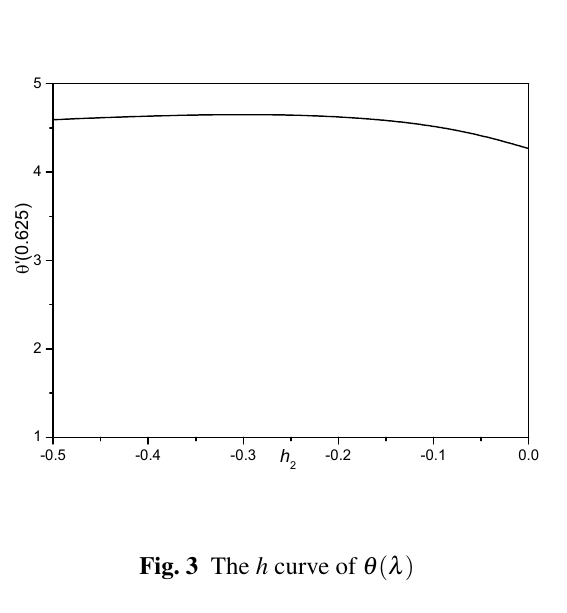
Fig. 2 The h curve of f ( λ )